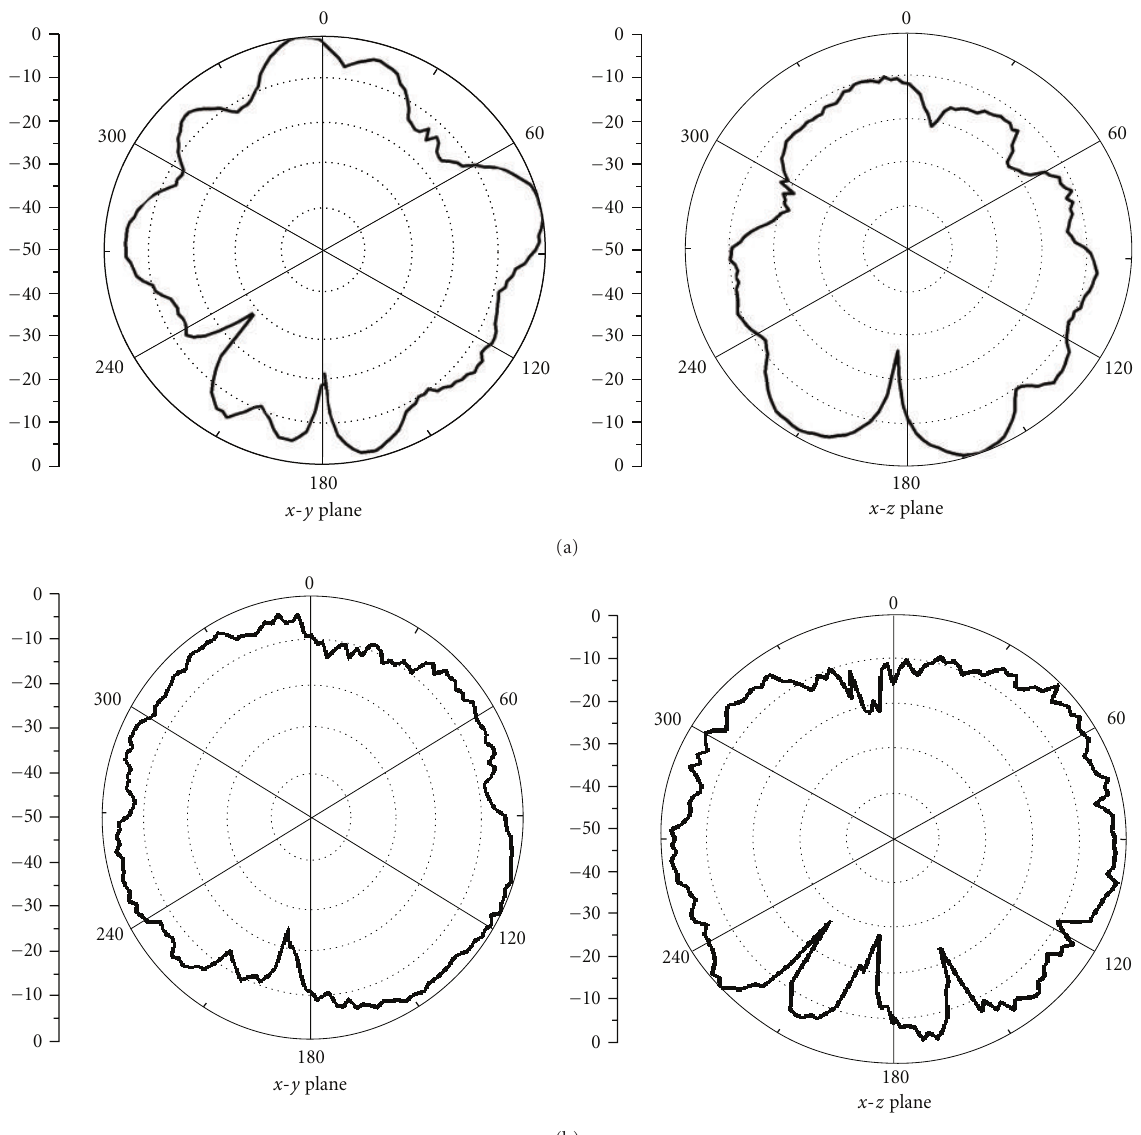
Figure 4: Measured radiation patterns of the proposed antenna (a) at 4.5 GHz (b) and